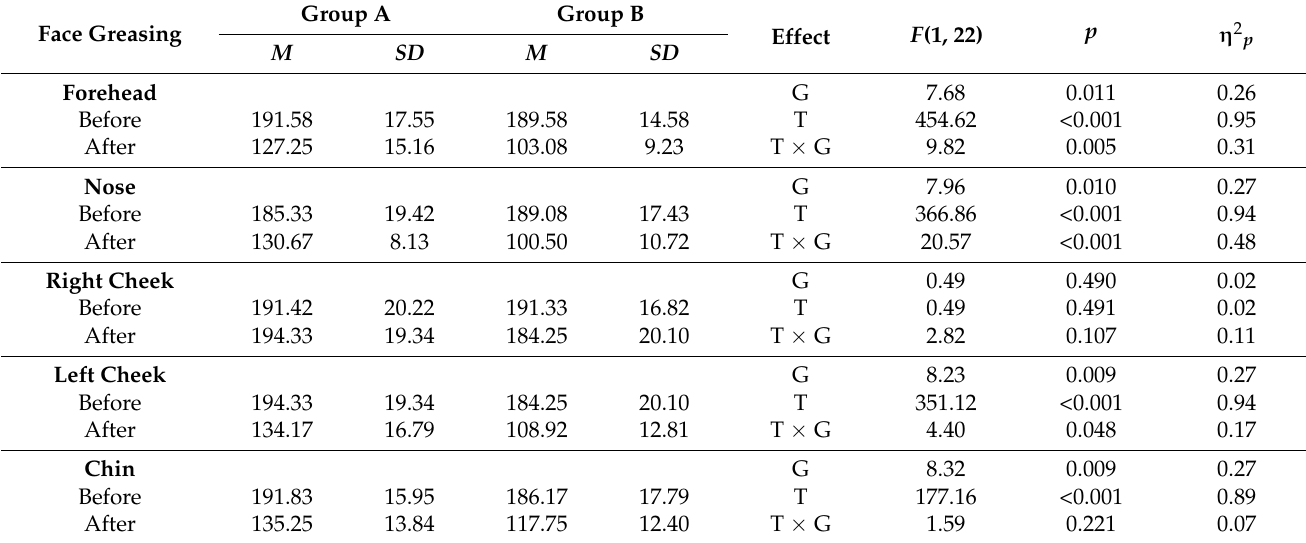
Table 3. Repeated measures one-way ANOVA for face greasing in groups A and B, before and after treatment, using Sebumeter SM815 ( µ g/cm 2